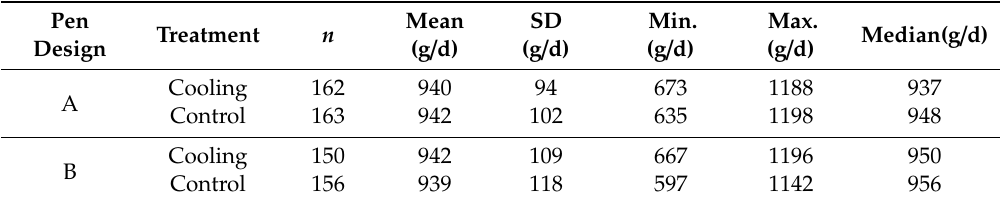
Table 3. Average daily weight gain for each pen design. n = number of pigs; usually 168 pigs per pen design and treatment. SD = standard deviation.